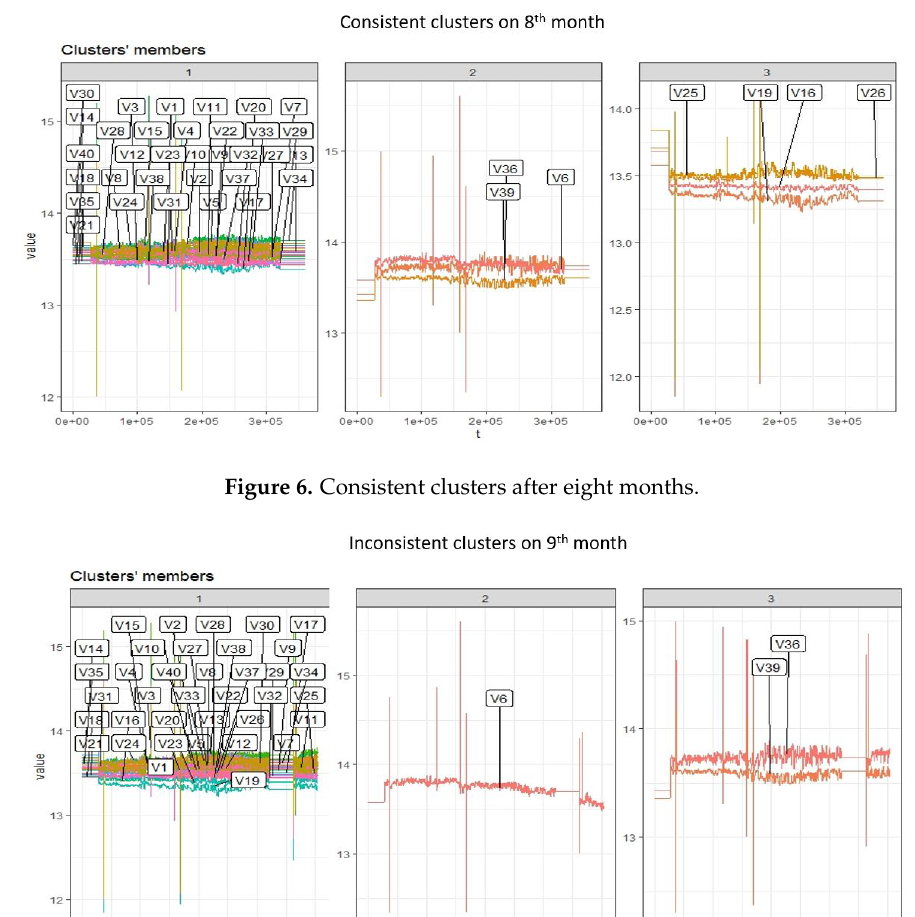
Figure 5. K-shape-based 1st month clusters.